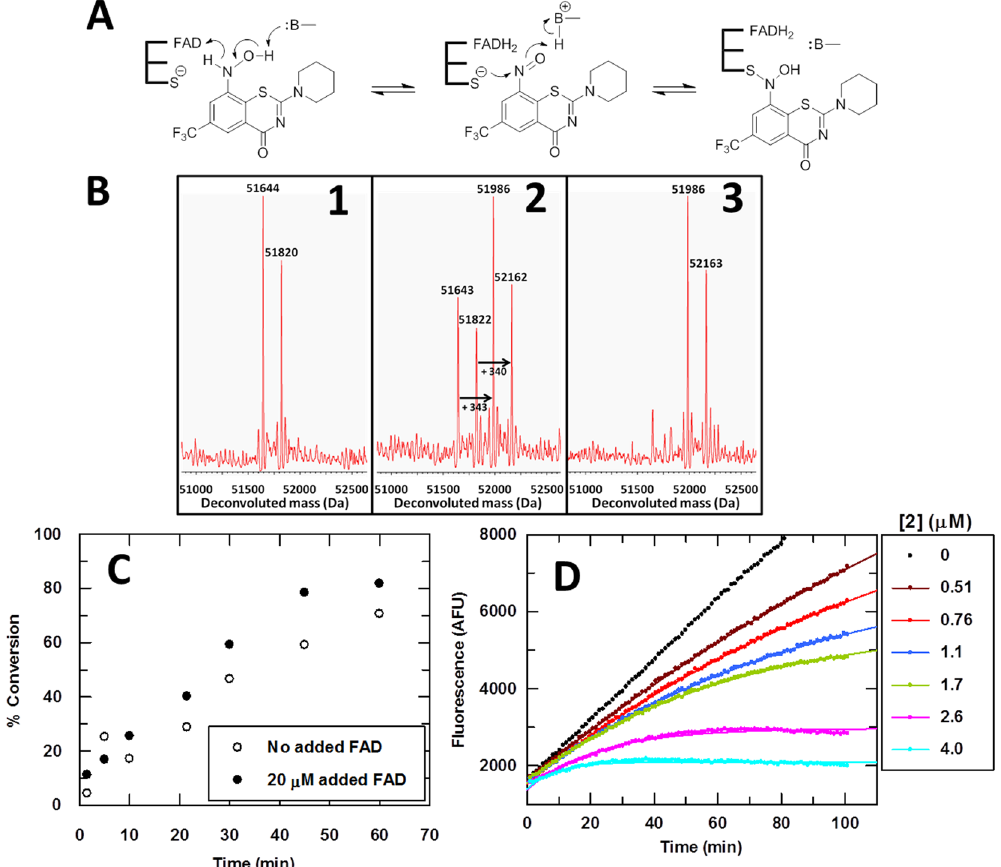
Figure 4. Covalent mode of inhibition of DprE1 by Hydroxylamino-BTZs. ( A ) Potential covalent mechanism of inhibition of Mtb-DprE1 by compound 2; ( B ) 1: Mass spectrum of Mtb-DprE1; 2: partial modification of Mtb- DprE1, 30 minutes after incubation with compound 2 and 20 μ M FAD; 3: complete modification of Mtb-DprE1, 60 minutes after incubation with compound 2 and 20 μ M FAD; ( C ) Time dependence of Mtb-DprE1 modification by 2 in the absence and presence of 20 μ M added FAD; ( D ) Enzyme inhibition progress curves for compound